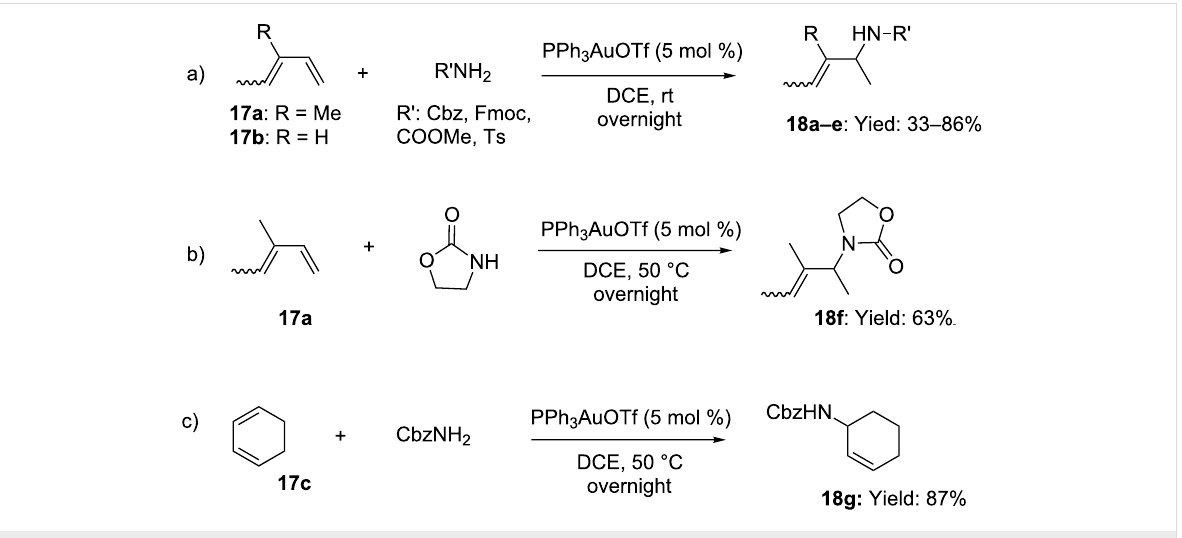
Scheme 6: [Au(I)]-catalyzed intermolecular hydroamination of